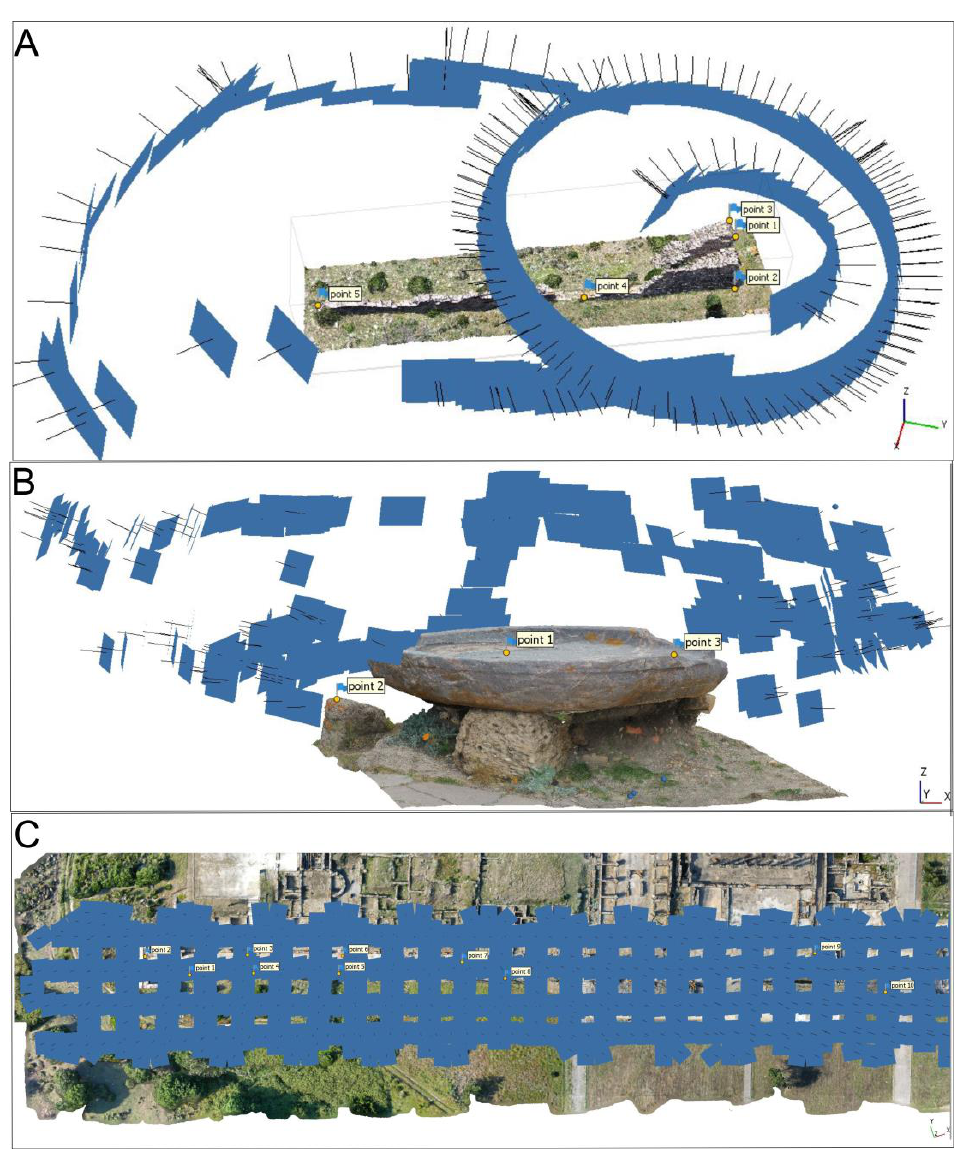
Figure 4. Different flight plans to obtain photographs from drone images. In each image, you can see the situation of the images taken by the drone and the control points taken on the ground. ( A ) Cameras for North City-Wall Bastion with two orbit flights. ( B ) Orbital flight plans and cameras for Marble dish tsunami. ( C ) Grid flight plan and cameras for Decumanus maximus .